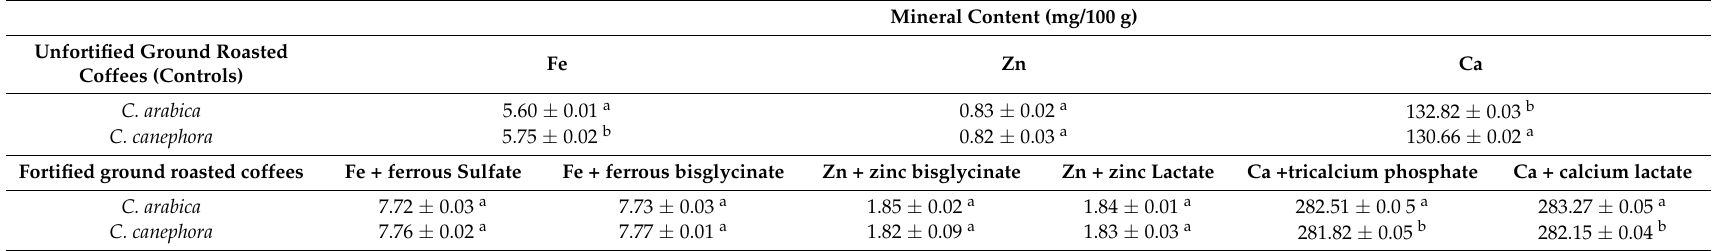
Table 2. Mean contents of iron, zinc, and calcium, measured using ICP-OES, in the unfortified (control) and fortified ground roasted coffees used for recovery evaluation in brews §